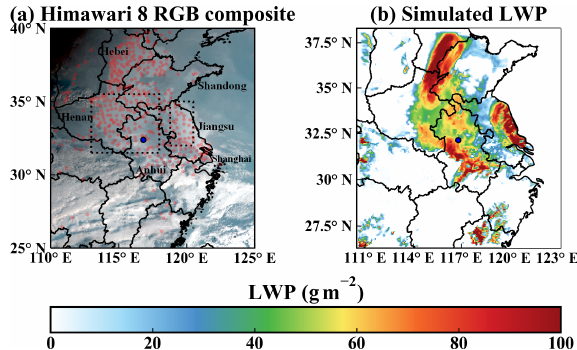
Figure 2. The performance of the simulated fog zone at 08:00 on 3 January 2017. (a) Himawari 8 RGB composite cloud image over- laid with the MICAPS observation sites (light red dots) at which fog was observed (relative humidity > 90% and VIS < 1km). (b) Sim- ulated LWP distribution. Only LWC values below 1500m are in- tegrated. The blue dots are the SX site. The two dashed rectangles in (a) are the sub-regions of interest in Fig. 3.